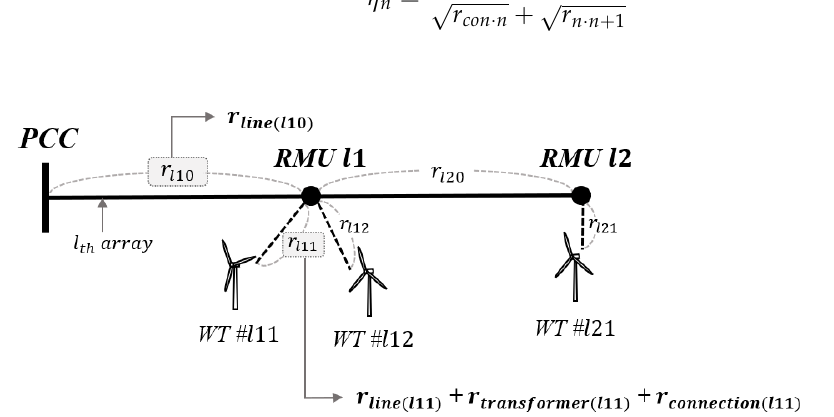
Figure 3. Reconfigured Dongbok wind farm structure.